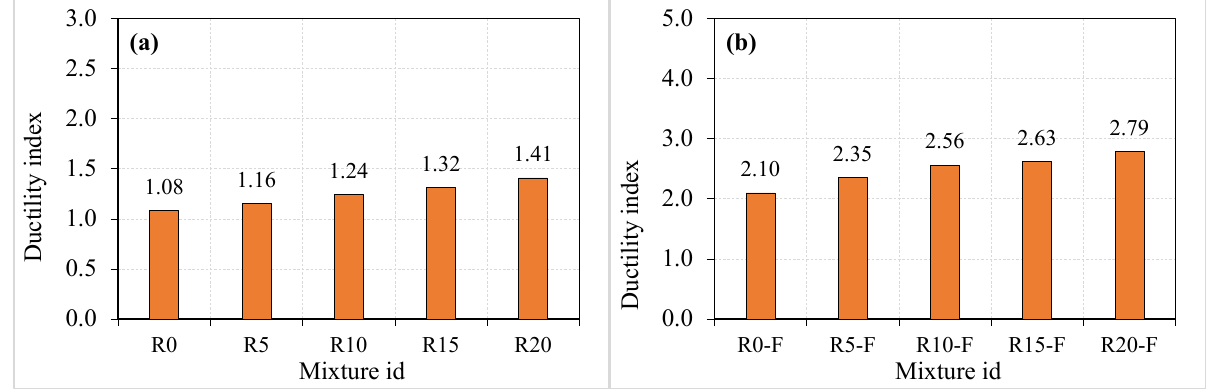
Figure 8. Impact ductility index of specimens ( a ) Non fibrous and ( b ) Fibrous.